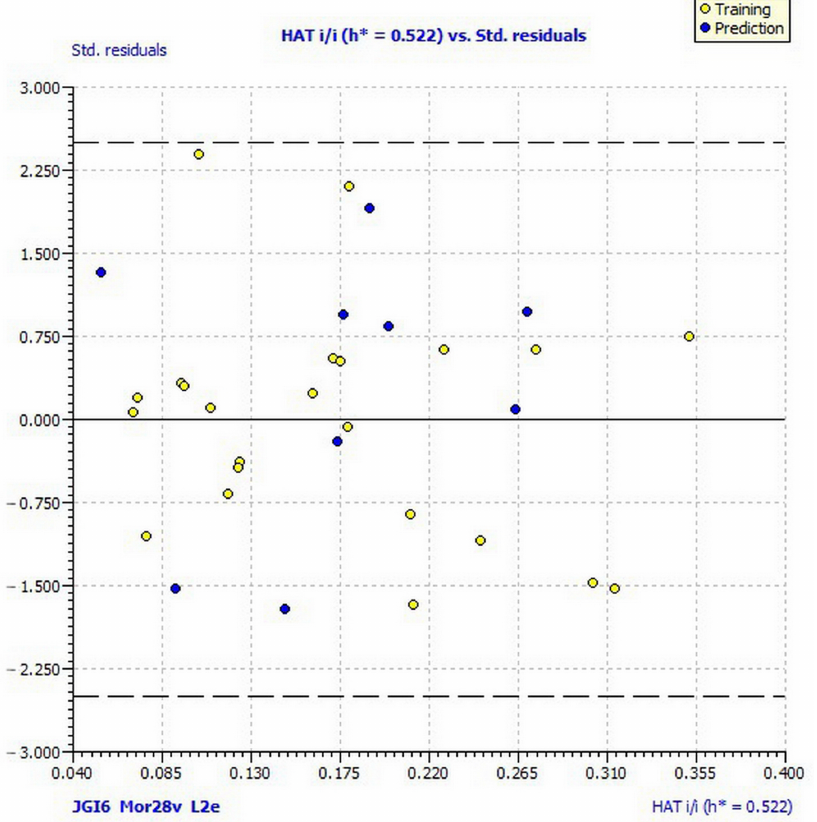
Figure 1. Williams plot of applicability domain of the QSAR model for inhibition of Macrophomina phaseolina calculated by model